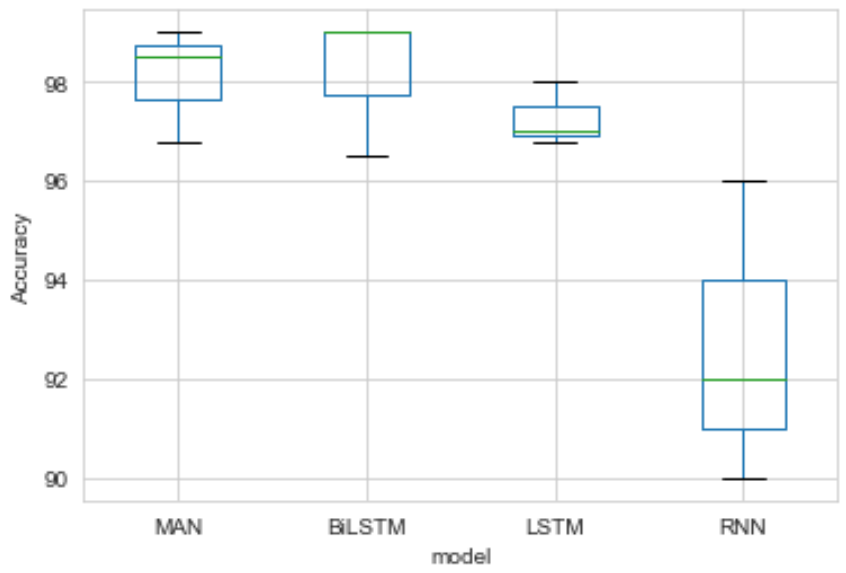
Figure 10. Distribution of quantitative of accuracy for different models in different